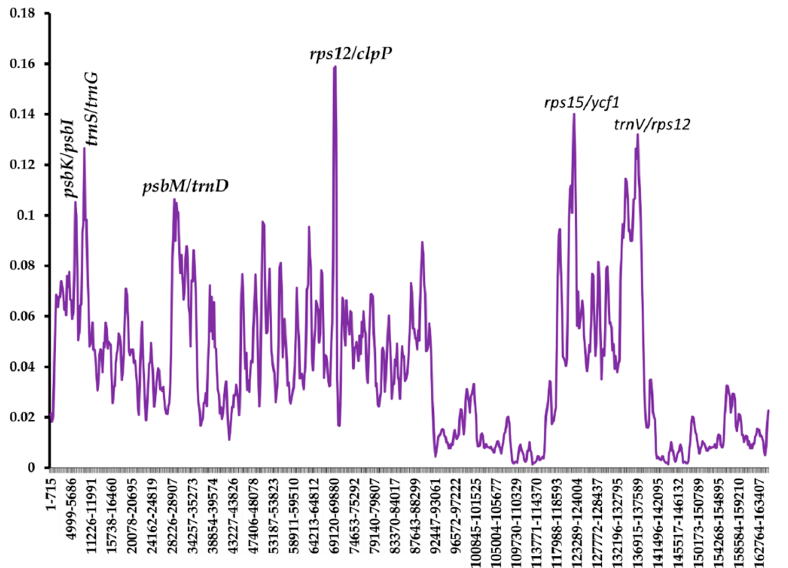
Figure 6. Nucleotide diversity of different regions of Asparagales chloroplast genomes.